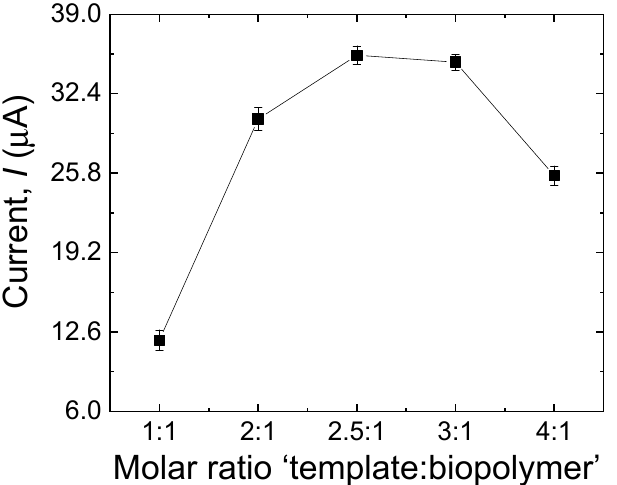
Figure 7. Effect of the template–biopolymer molar ratio during the electropolymerization process on the current response of the sensor to MDA (500 µM). Error bars are calculated from three independent replicates.